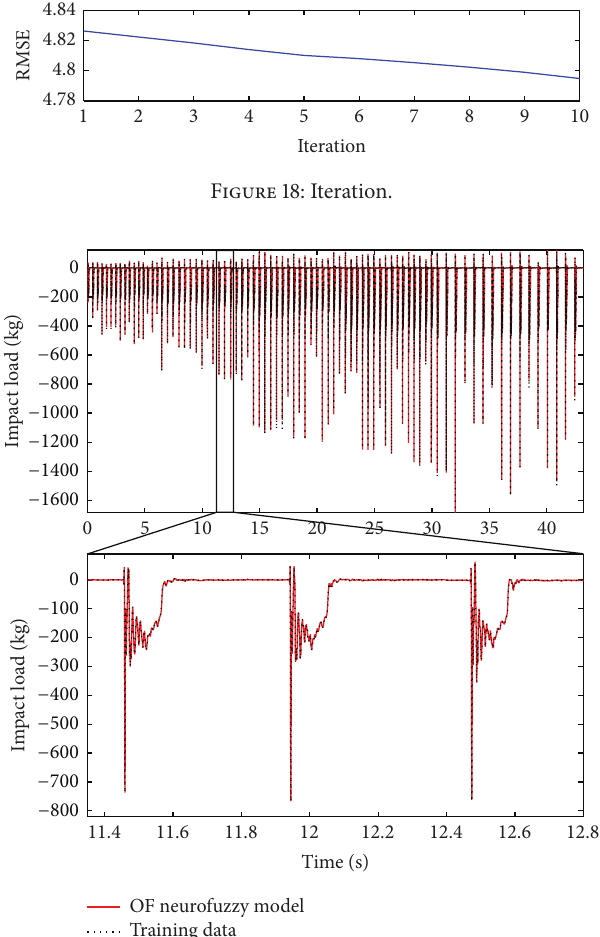
Figure 19: OF neurofuzzy training results: constant, sinusoidal, and random currents for different drop release